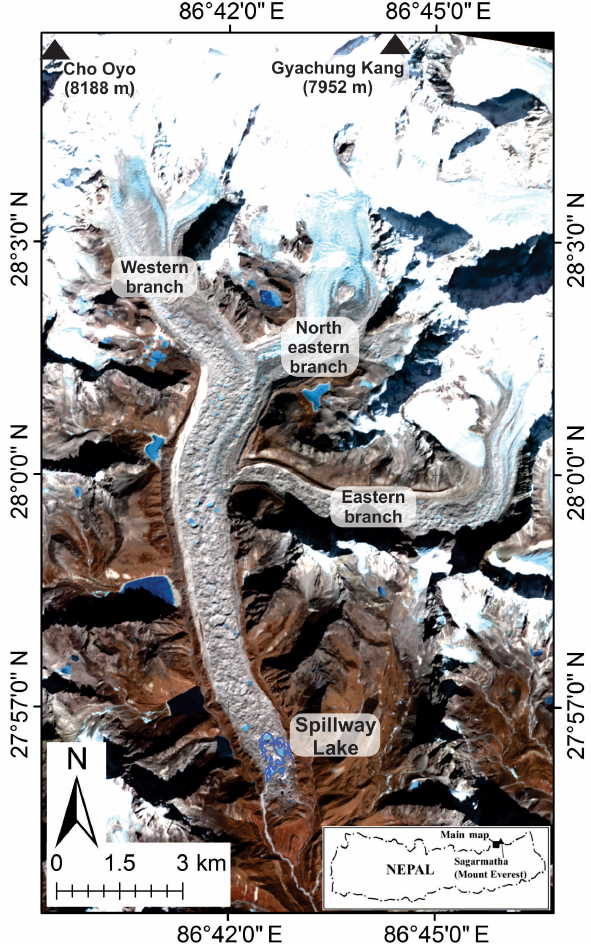
Figure 1. Ngozumpa Glacier, showing the location of the three branches and Spillway Lake. Image: orthorectified GeoEye-1 from December